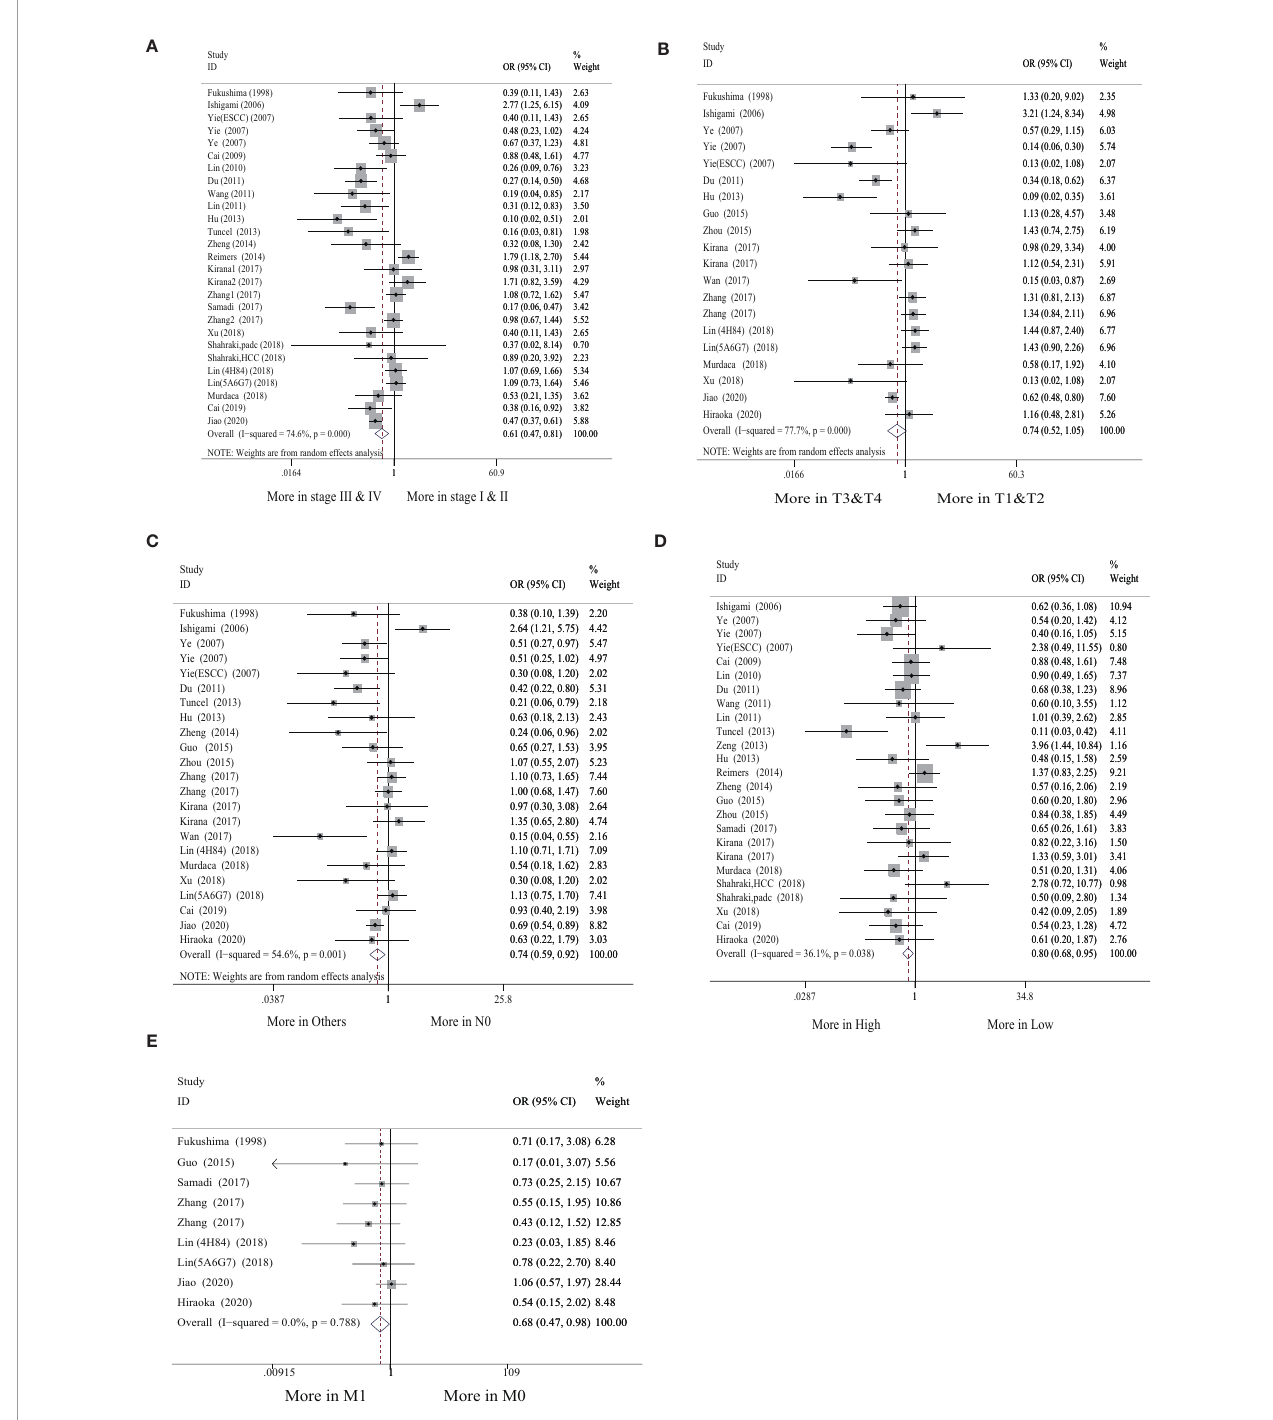
FIGURE 3 | Forest plot of other outcomes in the studies in the